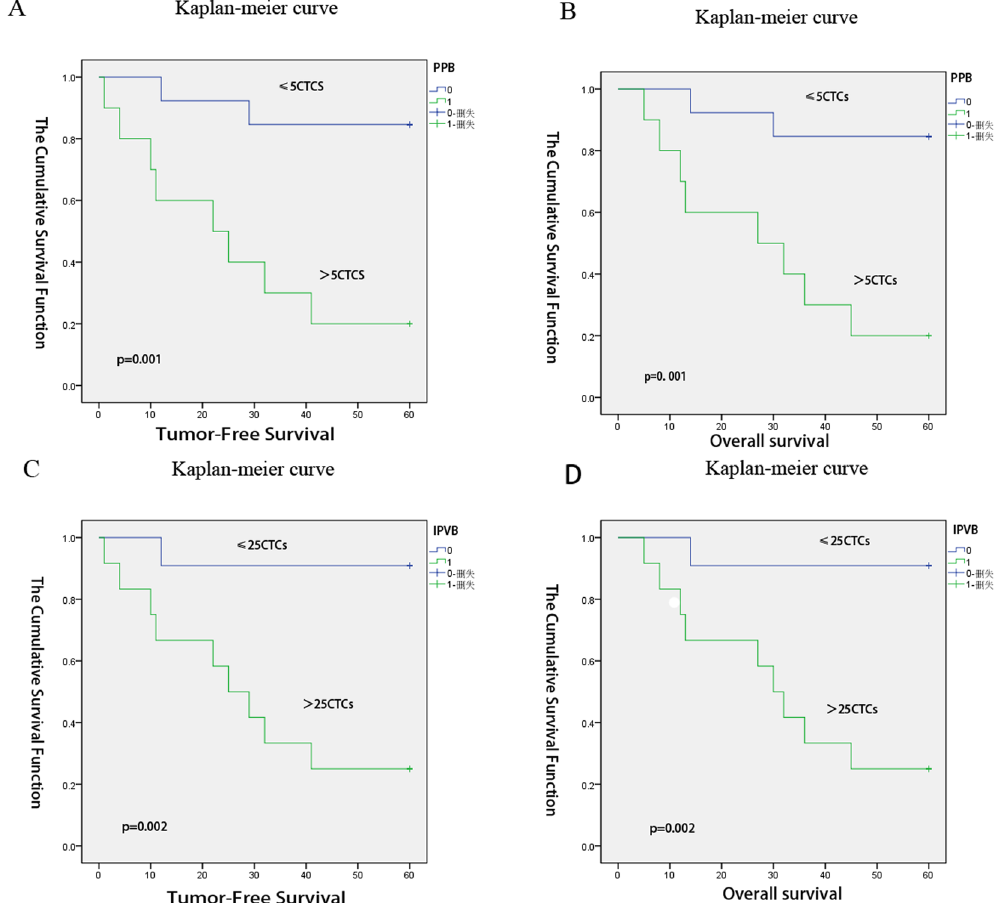
Figure 2. Kaplan–Meier estimates of probabilities of progression-free survival and overall survival in patients with non-small cell lung cancer at the follow-up times * . As shown in panels (A,B,C and D), the follow-up time for the study was 5 years. We defined NSCLC patients with PPB-CTC density > 5 CTCs/15 mL as the high-risk group and those with ≤ 5 CTCs/15 mL as the low-risk group. Panel A shows the probability of TFS according to the PPB-CTCs; the median TFS was 22.0 months for high-risk patients and > 60 months for low-risk patients, p = 0.001 via the log-rank test; Panel B shows the probability of OS according to the PPB-CTCs; the median was 27.0 months for high-risk patients and > 60 months for low-risk patients, p = 0.001 via the log-rank test. Using the IPVB specimens, we defined the patients with IPVB-CTC density > 25 CTC/15 mL as the high-risk group and those with IPVB-CTC density ≤ 25 CTCs/15 mL as the low-risk group. Panel C shows the probability of TFS according to the IPVB-CTCs; the median was 25.0 months for high-risk patients and > 60.0 months for low-risk patients, p = 0.002 via the log-rank test. Panel D shows the probability of OS according to the IPVB- CTCs; the median was 30.0 months for high-risk patients and > 60.0 months for low-risk patients, p = 0.002 via the log-rank test. Abbreviations: TFS: tumor-free survival; OS: over-survival; PPB-CTCs: peripheral blood circulating tumor cells; IPVB-CTCs: pulmonary venous blood circulating tumor